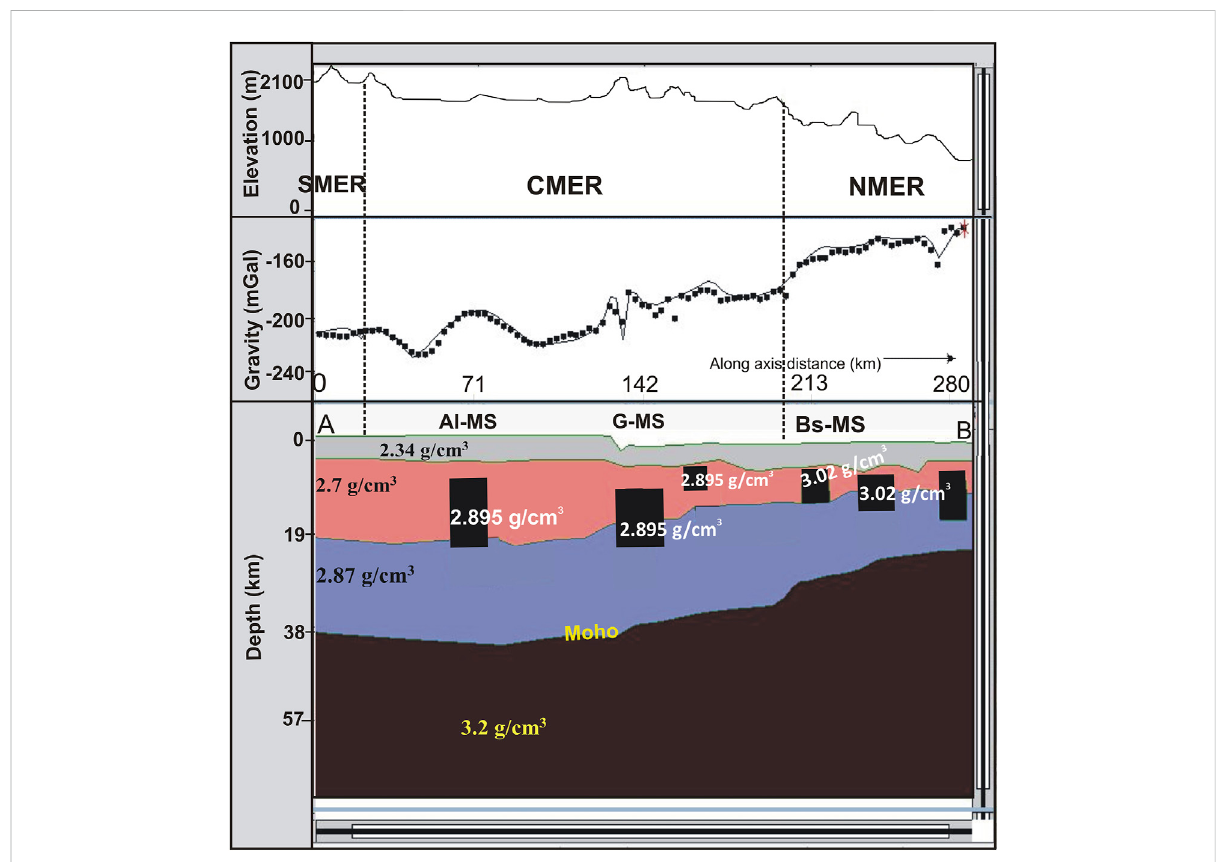
SMER, Southern MER; CMER, Central MER; NMER, Northern MER; Al-MS, Aluto magmatic segments; G-magmatic segments, Gedemsa magmatic segments; Bs-MS, Boseti magmatic segments.